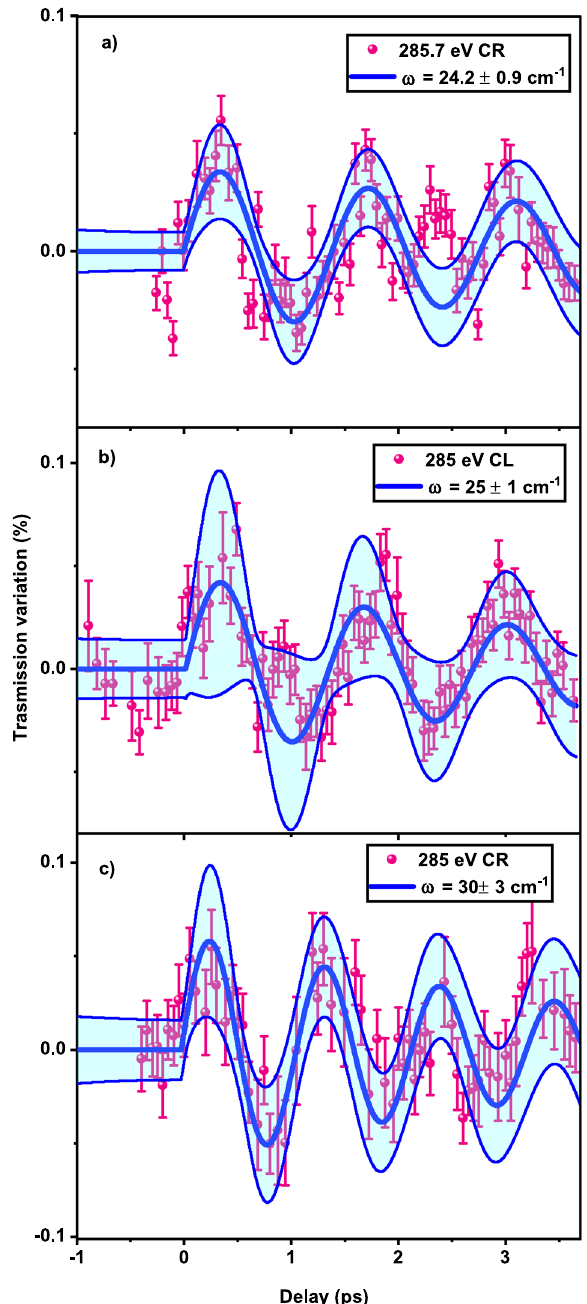
Fig. 3 | Time-resolved X-ray transmission signal. Time-resolved X-ray transmis- sion signal of the racemic IBP sample measured using probe pulses of: a 285.7eV withcircularrightpolarization: b 285eVwithcircularleftpolarizationand; c 285eV with circular right polarization. Thick blue lines are fi ts to the data with damped sinusoidal functions whose parameters are given in Table 1. Shaded cyan areas representsthe fi tcon fi dencebands. Errorbarsare calculated aserrorsofthemean value as described in ref. 65